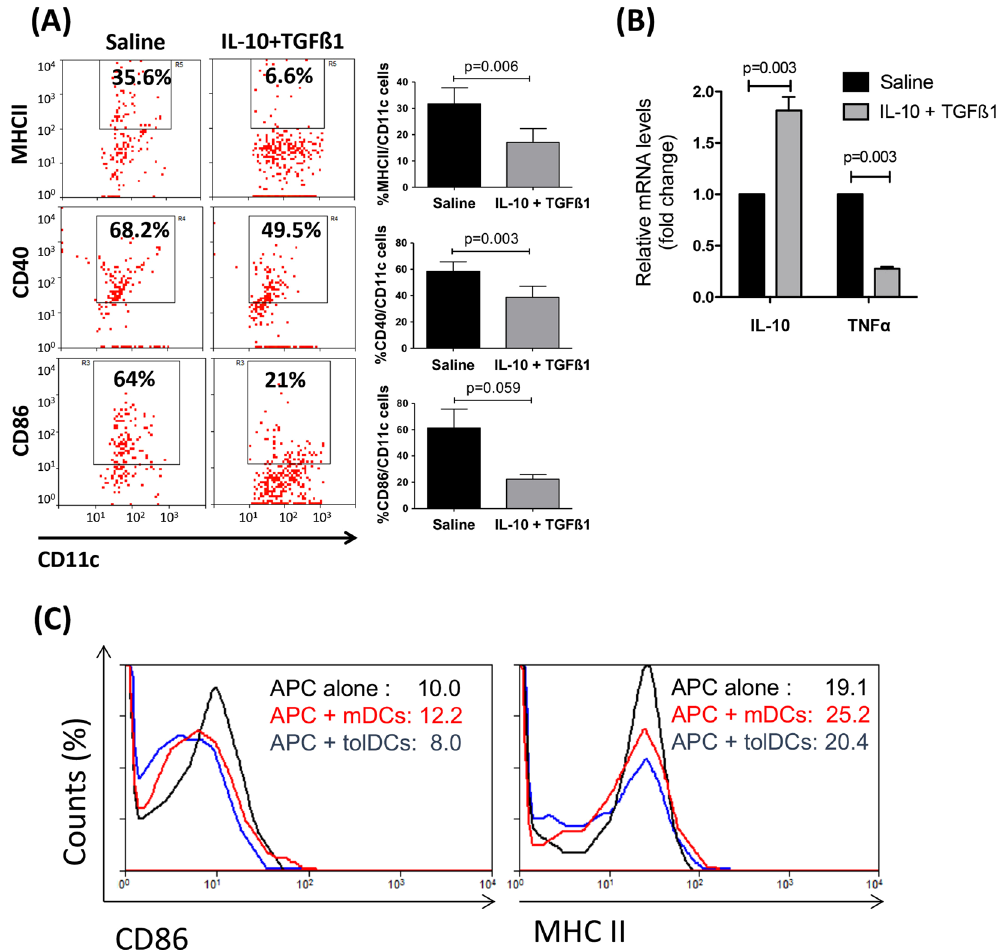
Figure 1. In vivo treatment of donor corneas with IL-10 and TGF β 1 induces tolerogenic APCs. Two days after single subconjunctival injection of IL-10 and TGF β 1, corneas were harvested and analyzed for the expression of maturation markers on dendritic cells ( A ) and mRNA expression of immunoregulatory and pro- inflammatory cytokines ( B ). ( A ) Flow cytometry analysis showing decreased frequencies of MHCII + CD11c + cells, CD40 + CD11c + cells, and CD86 + CD11c + cells in IL-10/TGF β 1-treated corneas compared to saline-treated controls (Bar graphs demonstrate mean ± SEM; N = 6 corneas/group, data shown are representative of three independent experiments). ( B ) Real-time PCR showing mRNA expression of IL-10 and TNF α in IL-10/TGF β 1- and saline-treated corneas 48 hours after injection before transplantation. Bar graphs demonstrate mean ± SEM; p < 0.003; N = 8 corneas/group. ( C ) Bone marrow-derived dendritic cells (DCs) were treated for 5 days in the presence or absence of IL-10/TGF β 1, and stimulated with LPS overnight to obtain tolerogenic DCs (tolDCs) or mature DC (mDCs), respectively. They were then co-cultured for 24 h with allogeneic splenic APCs of GFP + mice to distinguish them from bone marrow-derived DCs. Frequencies of GFP + APCs expressing MHCII and CD86 were quantified by flow